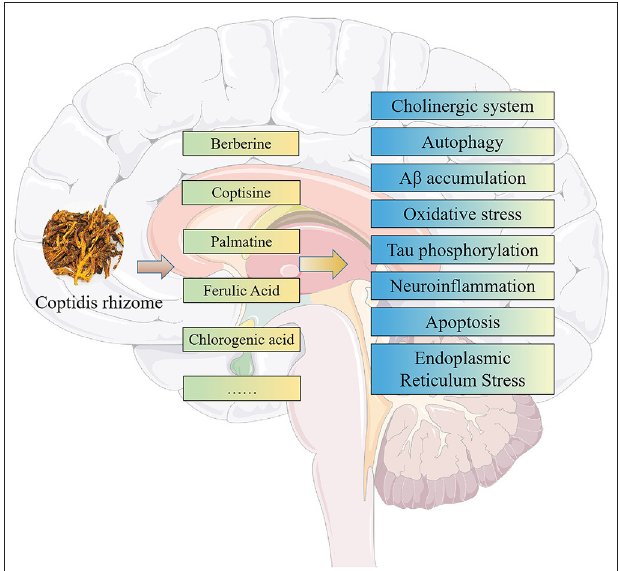
FIGURE 11 | Summary of CR involved in various pathological processes of AD.